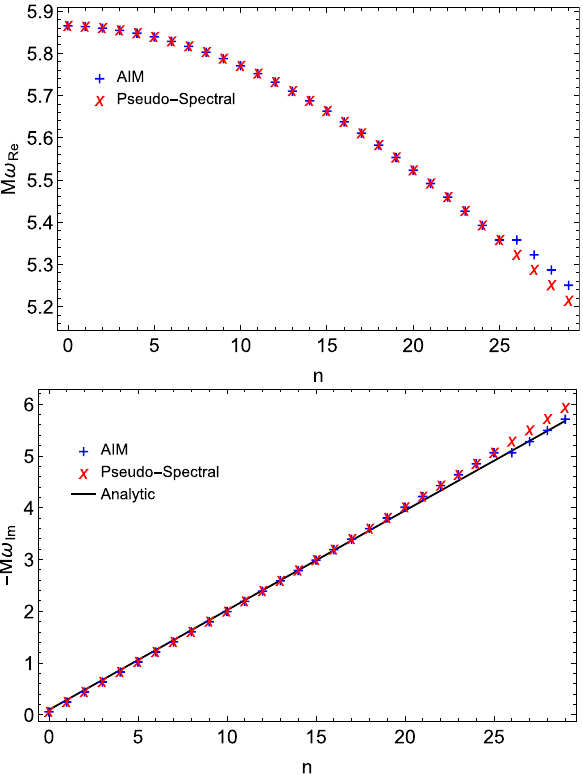
Fig. 2 The real (top panel) and imaginary (bottom panel) parts of the frequency as a function of n for the spin s = 0 field with (cid:6) = 30. The crosses ( + ) represent the AIM results, the exes (x) indicate the pseudo- spectral, while the solid black line in the bottom panel is the plot of the function M ω Im given in Eq. (55)